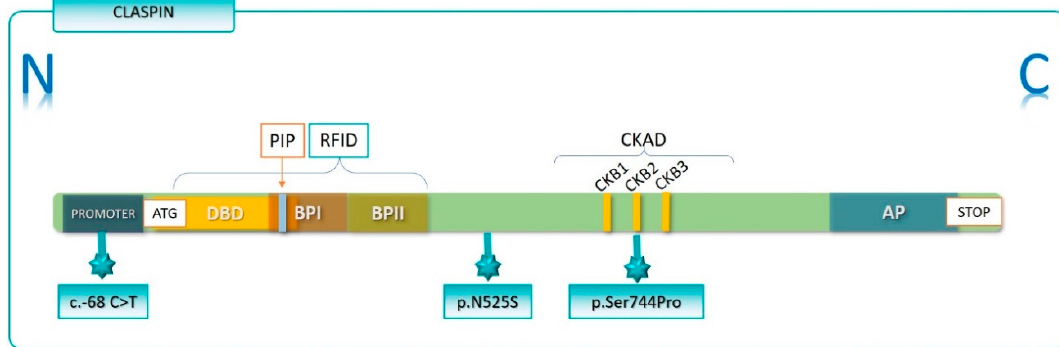
Figure 8. Claspin functional domains and location of the genetic variants. The N terminal end of Claspin contains the replication fork-interaction domain (RFID) (aa 273-622), which harbours two smaller regions rich in basic residues termed basic patches 1 (BP1) (aa 273–492) and 2 (BP2) (aa 492–622), and the PCNA-interacting domain (PIP). RFID mediates interactions with replication associated proteins and contributes to Claspin physical interaction with chromatin-containing stalled replication forks. The DNA binding domain (DBD) that spans aa 149 to aa 340 efficiently interacts with branched DNA. The C terminal end harbours an acidic patch (AP) that interacts with the DNA-binding domain (DBD) domain located in the N terminal region. The Chk1-activating domain (CKAD) is located in the C terminal spanning aa 837 to aa 1206. This region contains three 10 aa repeats phosphorylation sites in human Claspin (CKB1: aa 910-919; CKB2: aa 939-948 and CKB3: aa 976-985) that are CK γ 1 kinase phosphorylation targets and are involved in Chk1 binding and activation.